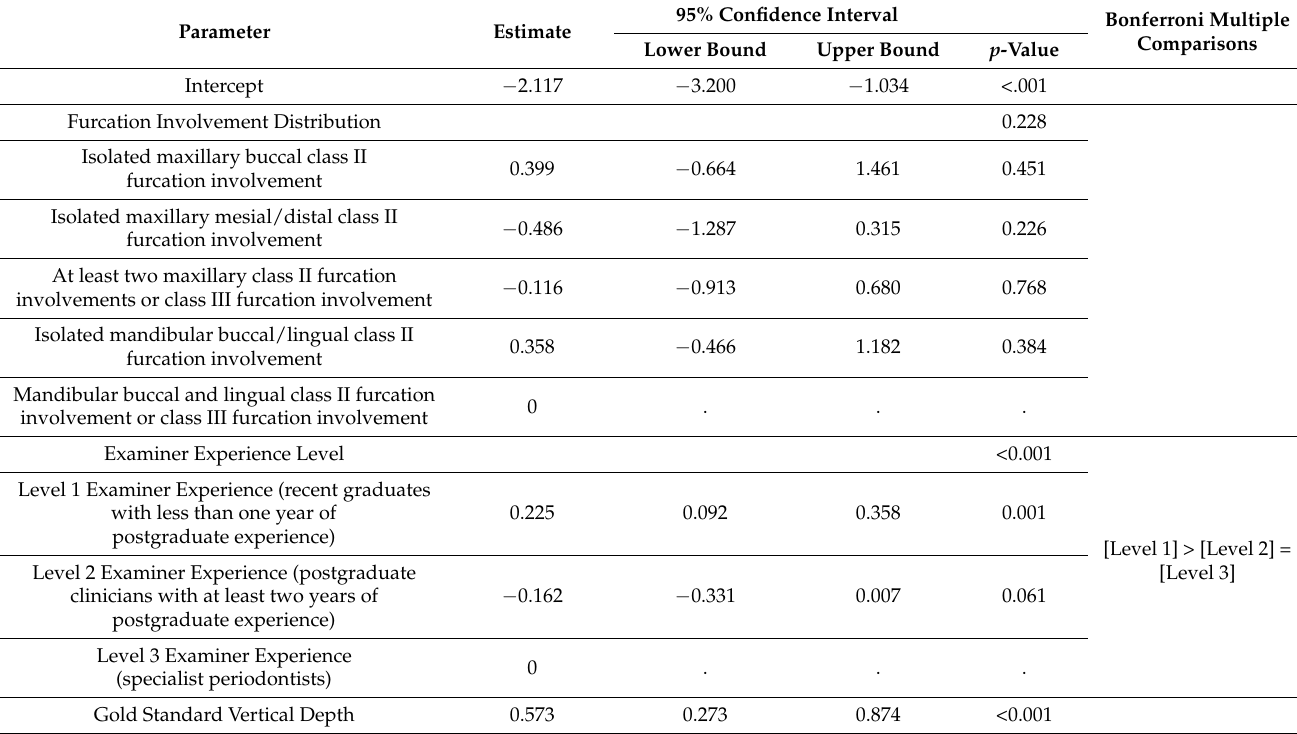
Table 6. The relationship between bias in vertical depth of furcation involvement measurement, furcation involvement distribution, and examiner experience level in the linear mixed model (adjusted for gold standard vertical depth of furcation